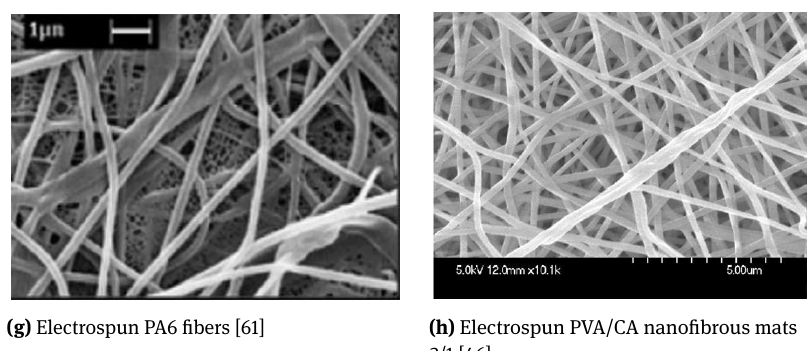
Figure 11: (a-h) show the scanning electron micrographs of some electro-spun